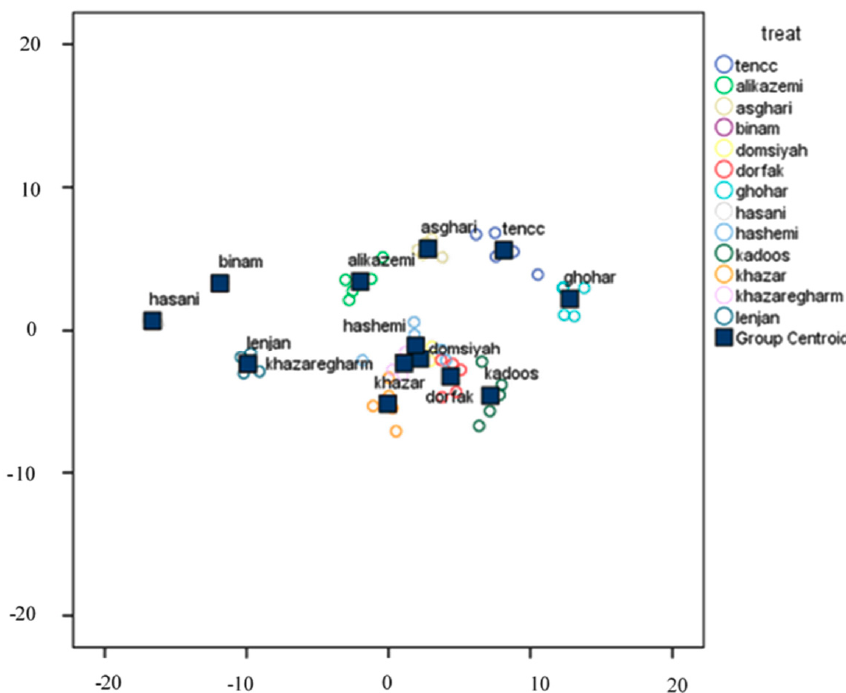
Figure 17. Classification of 13 white rice cultivars using linear DA.